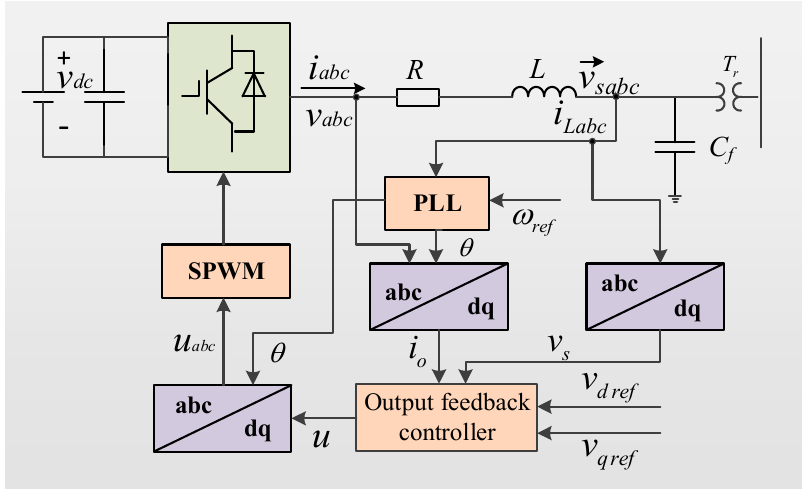
Figure 1. Schematic diagram of the DG structure in islanded microgrid.